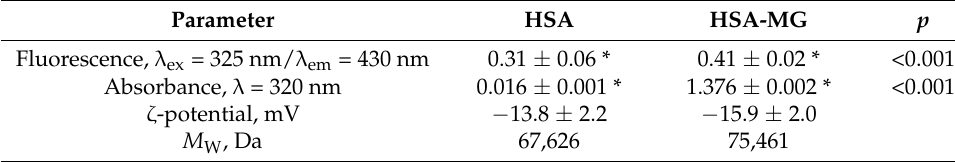
Table 1. Characteristics of HSA and HSA-MG. Parameter HSA HSA-MG p Fluorescence, λ ex = 325 nm/ λ em = 430